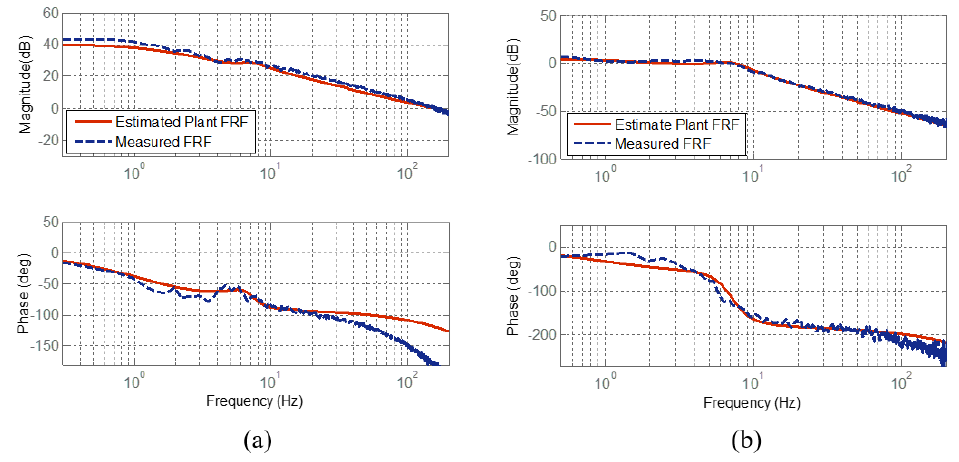
Figure 15. Frequency Response Functions of cRSEA [25]. ( a ) FRFs from motor torque to motor velocity and ( b ) FRFs from motor torque to spring deformation.